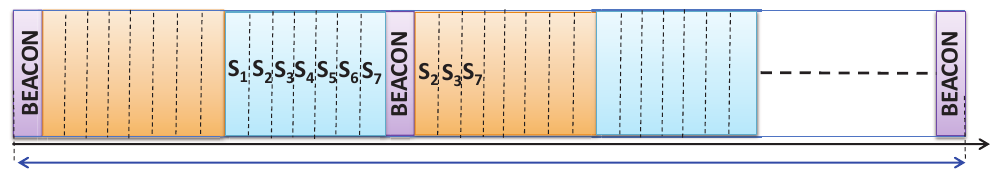
Figure 4. Dynamic GTSR allocation for the failed GTS